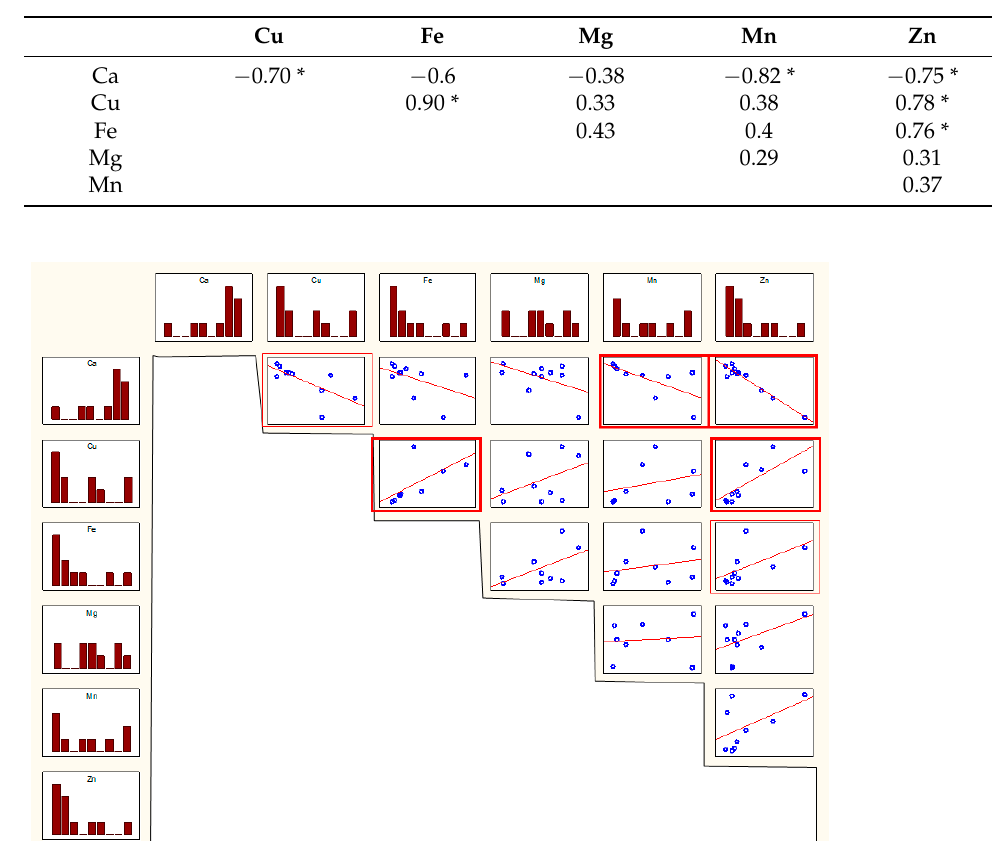
Table 3. The values of the correlation coefficients for the content of analytes in the tissue of women, considering Cd, Cr, and Pb. Statistically significant values are marked with an